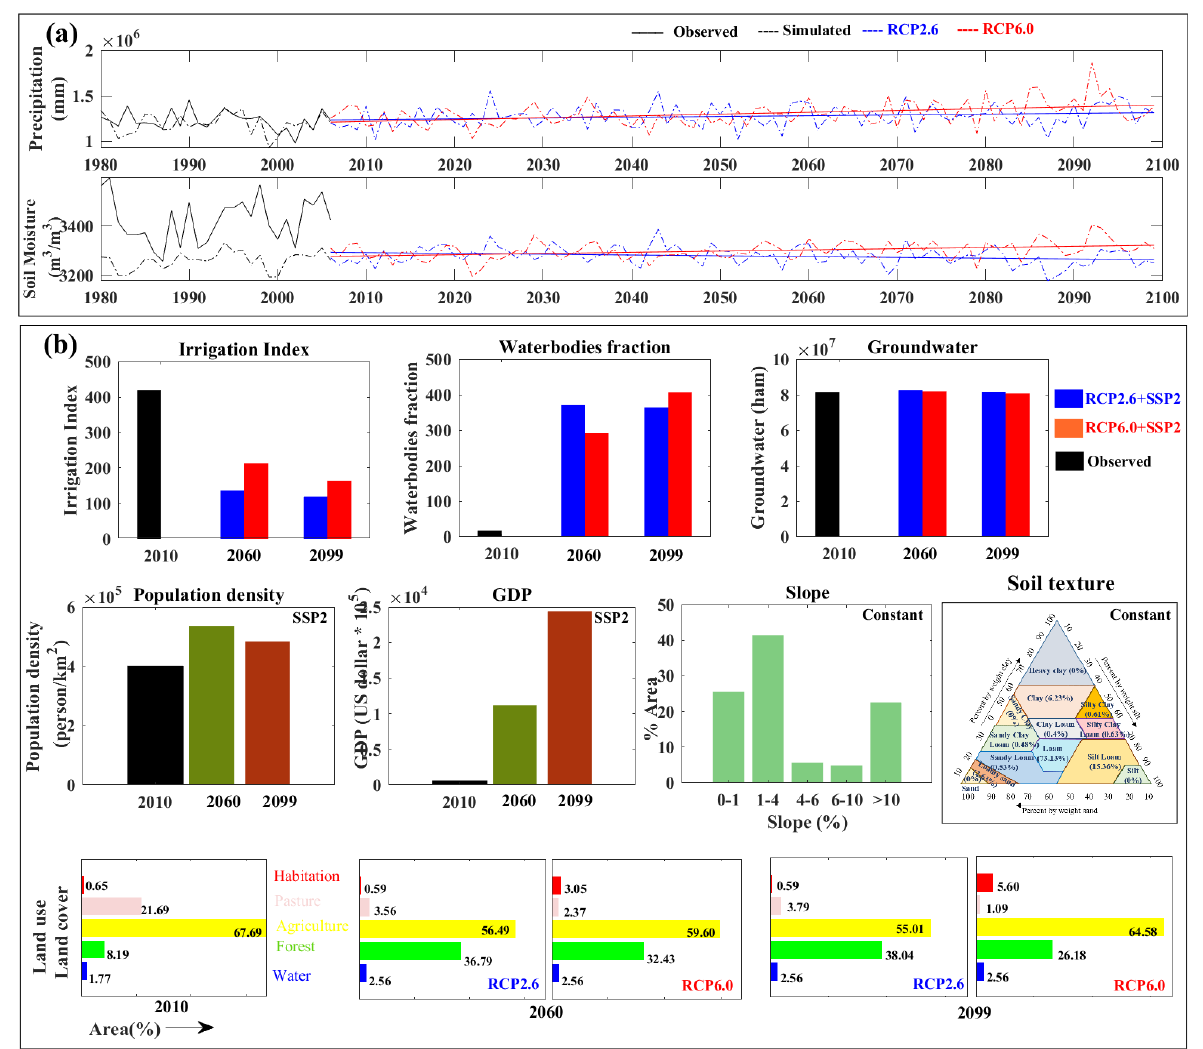
Figure 2. Datasets used for drought risk assessment. (a) Projected hydro-climatic variables such as monthly precipitation and monthly soil moisture are used for drought hazard assessment. (b) Projected drought vulnerability indicators such as irrigation index, waterbody fraction, groundwater availability, population, GDP and land use land cover, along with static drought vulnerability indicators such as slope and soil texture, are used for drought vulnerability assessment. Datasets for projected period are divided into near future (2021–2060) and far future (2061–2100) to check the evolution of drought